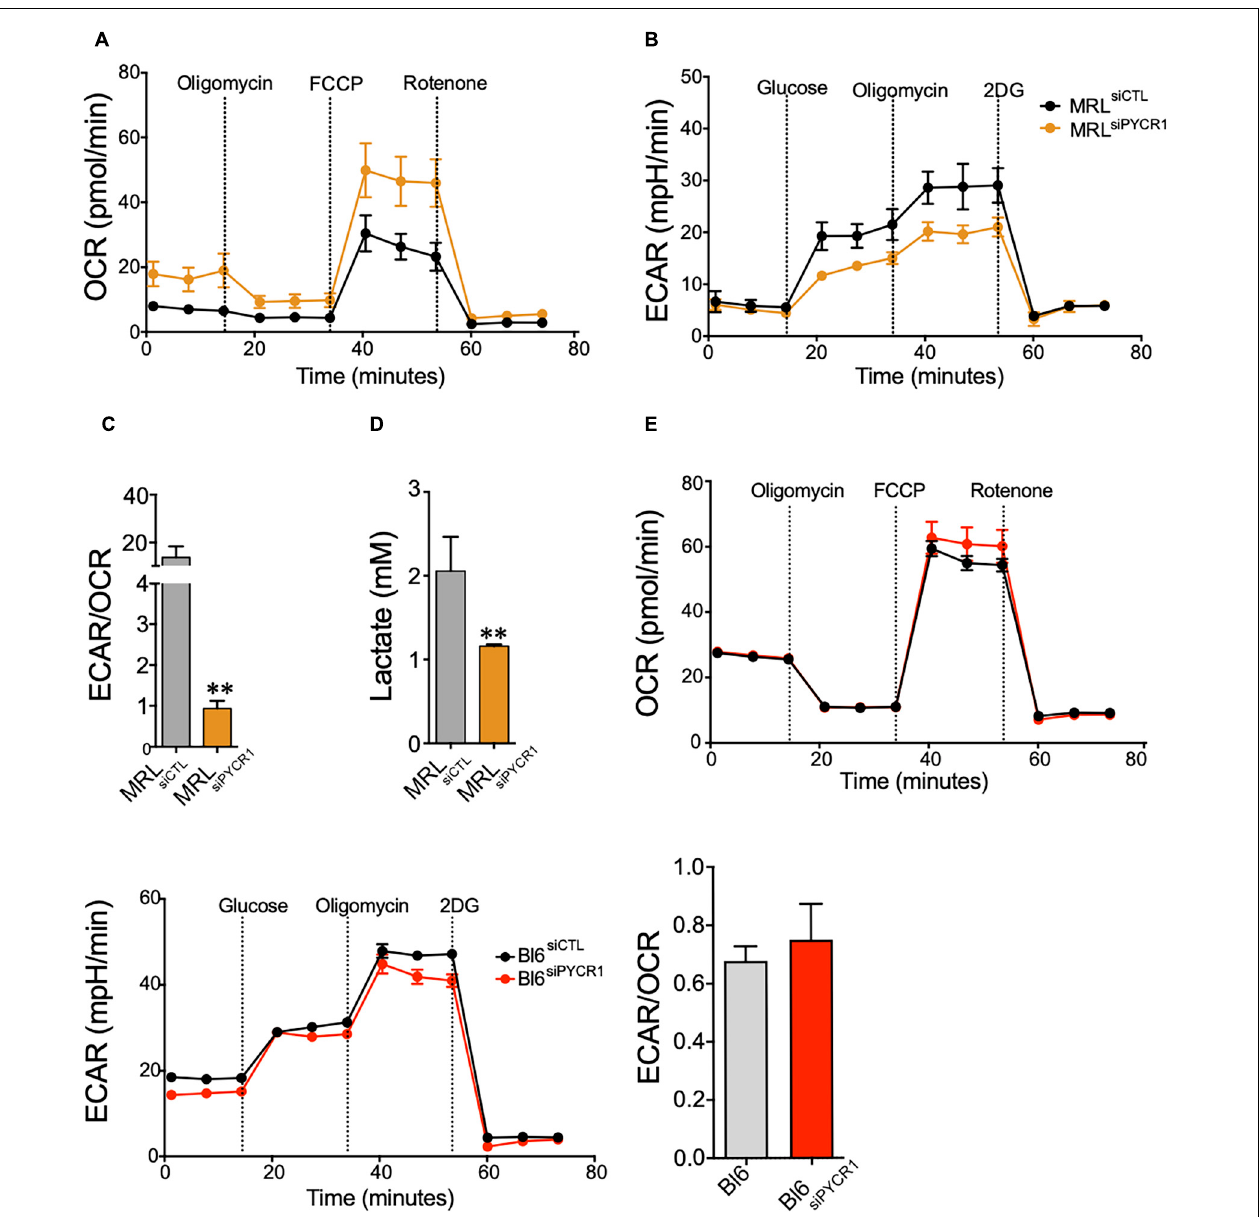
FIGURE 3 | Pycr1 induces a glycolytic metabolism on MRL MSCs. (A,B) The metabolic activity of MRL MSC siCTL (MRL MSCs transfected with the siCTL siRNA) control (black line) and siPYCR1 (orange line) was evaluated by measuring the OCR (A) or the ECAR (B) with Seahorse analyzer. The knockdown of Pycr1 affects both the OCR and ECAR profiles, which translates to a preferentially oxidative metabolism. (C) The ratio between glycolytic rate and basal OCR confirms a significant decline in the glycolytic metabolism of MRL siPYCR1. (D) Similarly, we observed a significant decrease in lactate concentration in the extracellular media, as a result of the diminished glycolytic activity on MRL siPYCR1, compared with MRL siCTL. Results represent the mean ± SEM of three independent experiments with five different replicates each time. Statistics: Mann–Whitney unpaired t -test. ∗∗ : p < 0.01. (E) The metabolic activity of BL6 MSC siCTL and BL6 MSC siPYCR1 was evaluated by measuring the OCR, ECAR and the ratio ECAR/OCR with Seahorse analyzer. MRL, Murphy Roths Large; MSCs, mesenchymal stem cell; siRNA, small interfering